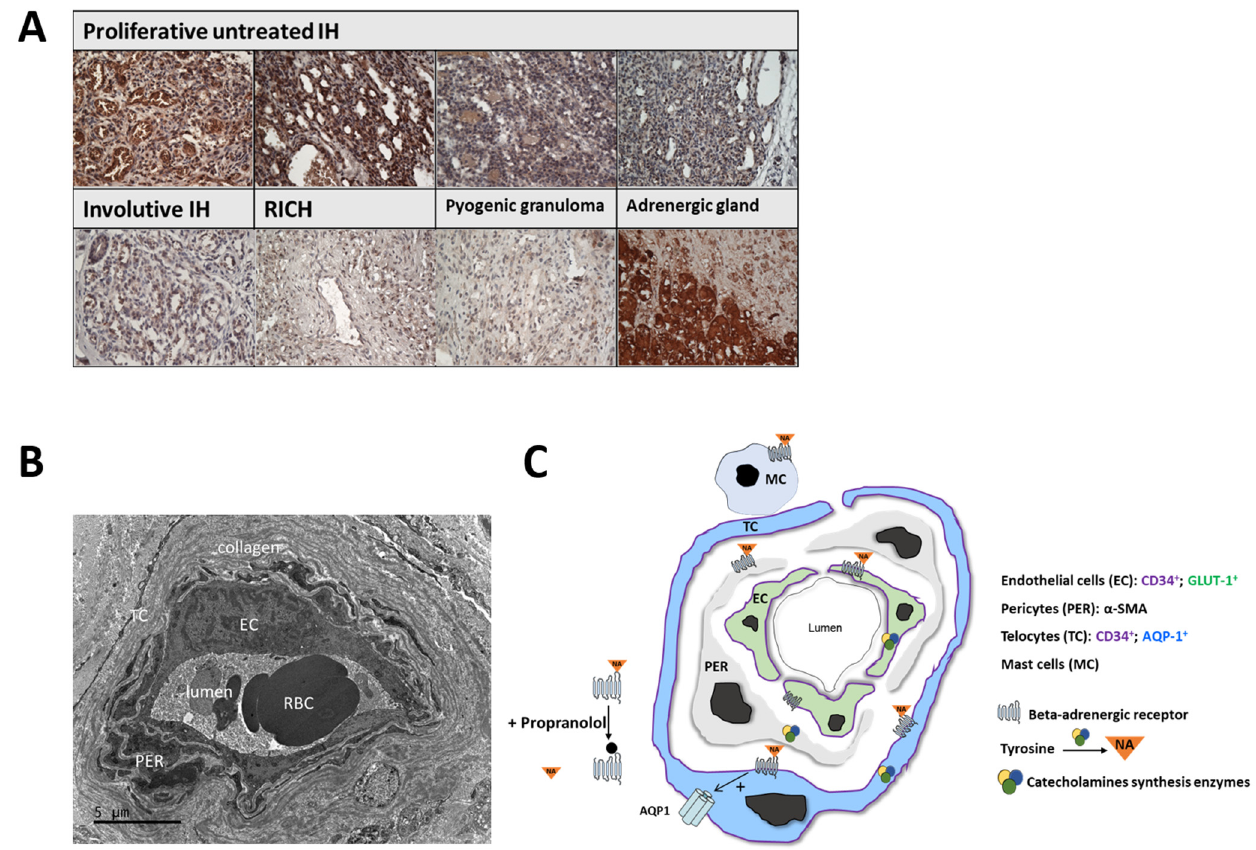
Figure 5. Proliferative IH tissues present some features of neuroendocrine tumors. ( A ) Immunostain- ing for Chromogranin A (CgA) counterstained with hemalun. CgA-positive cells appear in brown. Scale bar size is 100 µ m. While high expression levels of CgA are detected in untreated proliferative IHs, low levels are detected in involutive IHs and other vascular tumors, including rapidly involutive congenital hemangiomas (RICH) and pyogenic granulomas. The adrenal gland used as a positive control. ( B , C ) Model outlining IH responses to propranolol. ( B ) Electron microscopy of IH vessel showing endothelial cells surrounded by pericytes and telopodes of telocytes in perivascular space. Scale bar size is 5 µ m. ( C ) IH-EC, -PER and -TC express the first three enzymes involved in cate- cholamine biosynthesis pathway, enabling them to release NA locally. Our previous data [17,27] demonstrated that beta-adrenergic receptors are present on IH-EC, -PER, -TC and mast cells. It is likely that NA-mediated activation of ADRB in an autocrine and/or paracrine manner results in binding to ADRB receptors. NA: noradrenaline, IH: infantile